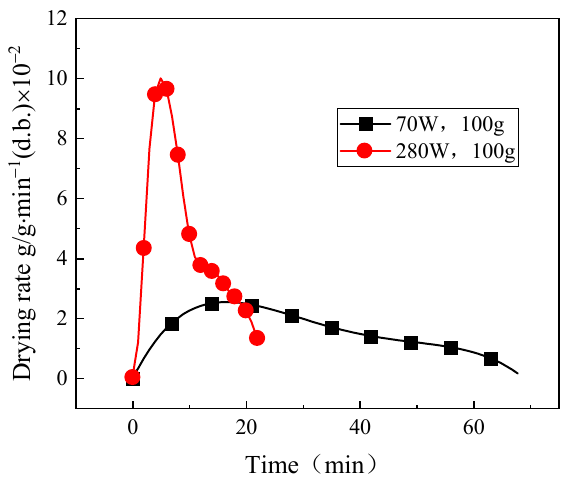
Figure 3. Drying rate of corn under different microwave powers.